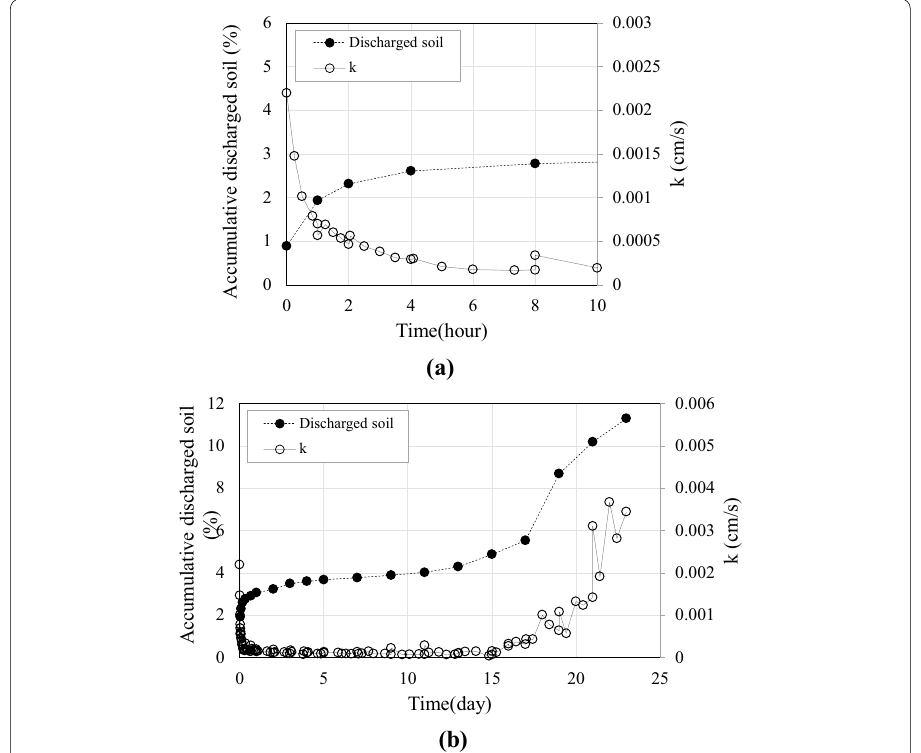
Fig. 6 Long‑term test results of Gwanak soil: accumulative discharged soil and k for a 10 h and b 23